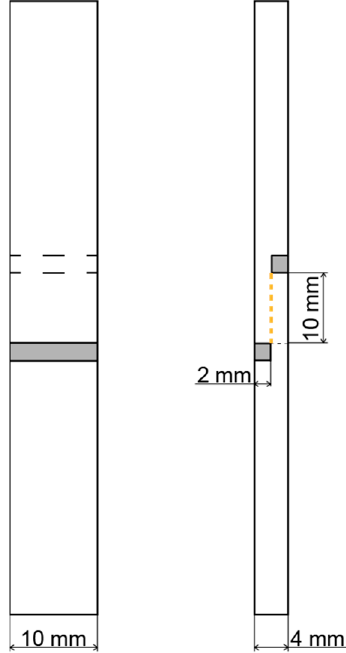
Z020 (Zwick GmbH & Co., Ulm, Germany) universal testing machine at room temperature.